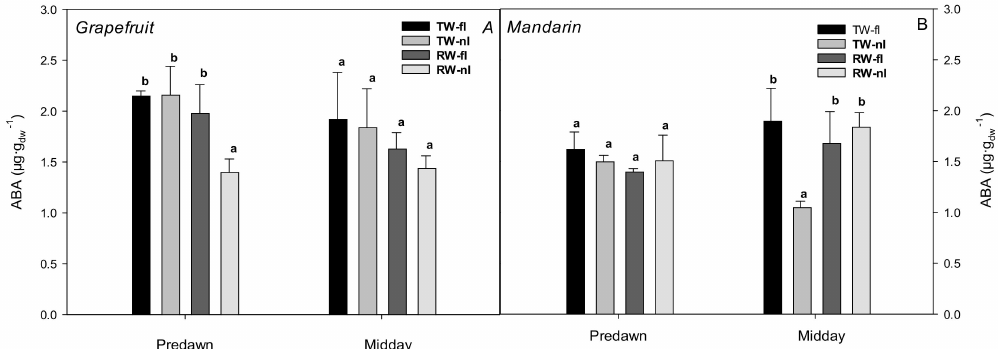
Figure 3. Leaf ABA content for grapefruit ( A ) and mandarin ( B ) and for each treatment (TW-fI: transfer water—fully irrigated; TW-nI: transfer water—non-irrigated; RW-fI: reclaimed water—fully irrigated; RW-nI: reclaimed water—non- irrigated). Each value is the average of 4 blocks, collected at 248 DOY. The bars denote the standard deviations of the mean. Within each sampling and crop, different letters indicate significant differences at p < 0.05, as assessed using Tukey’s